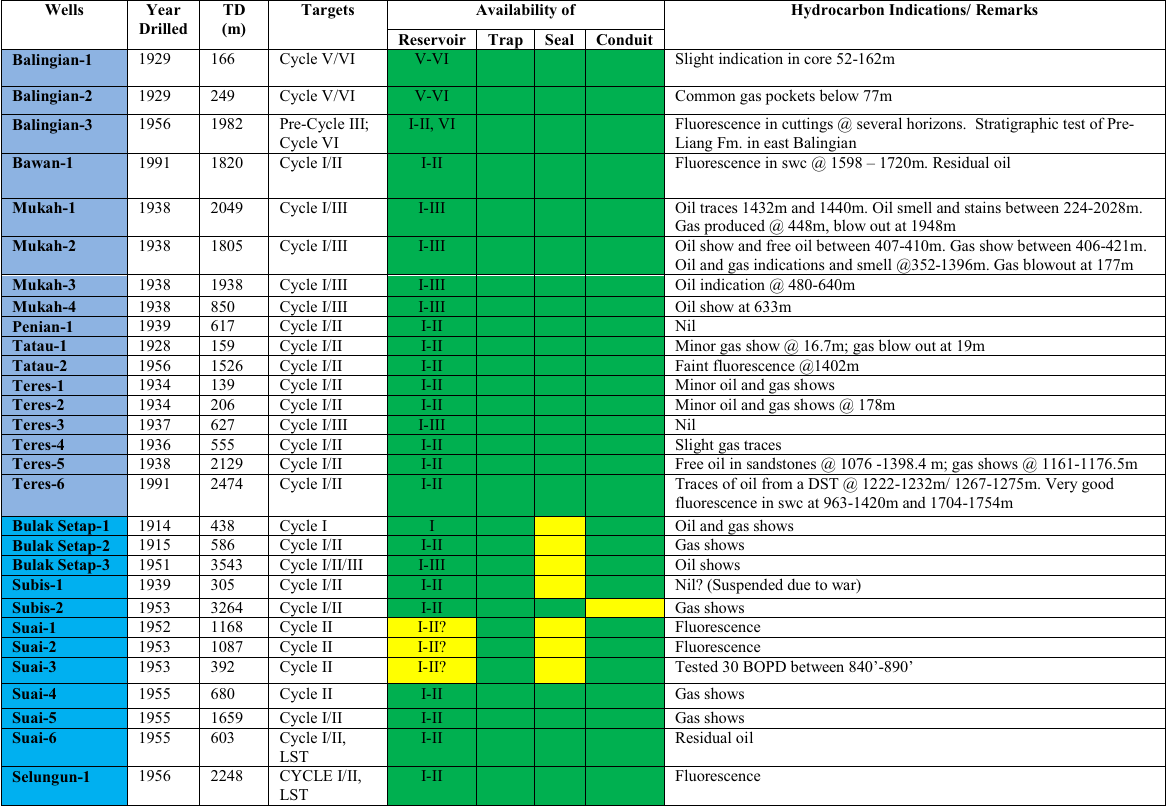
*TD is total depth. Approximately 90% of the wells targeted Pre-Cycle IV sequences with over 50% having relatively shallow depth (<1000m). Indicators of hydrocarbon were observed in a good number of them.